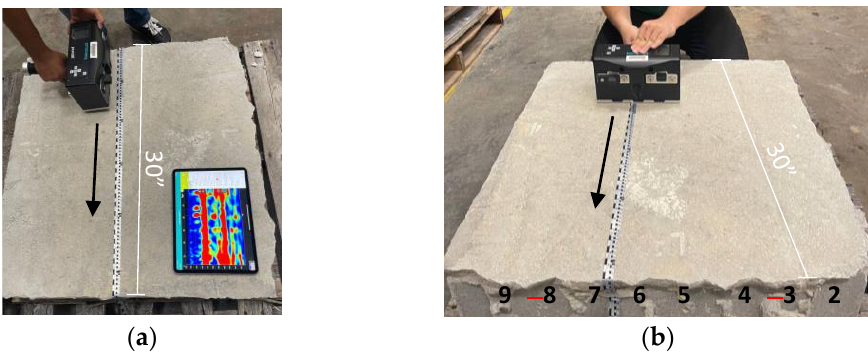
Figure 6. Phased array with angled wavefront [112].